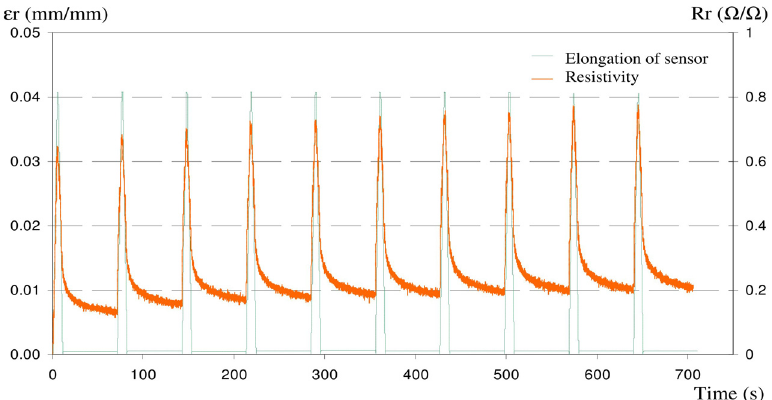
Figure 7. Electrical response of sensor (Rr) during 10 elongation cycles ( ε r